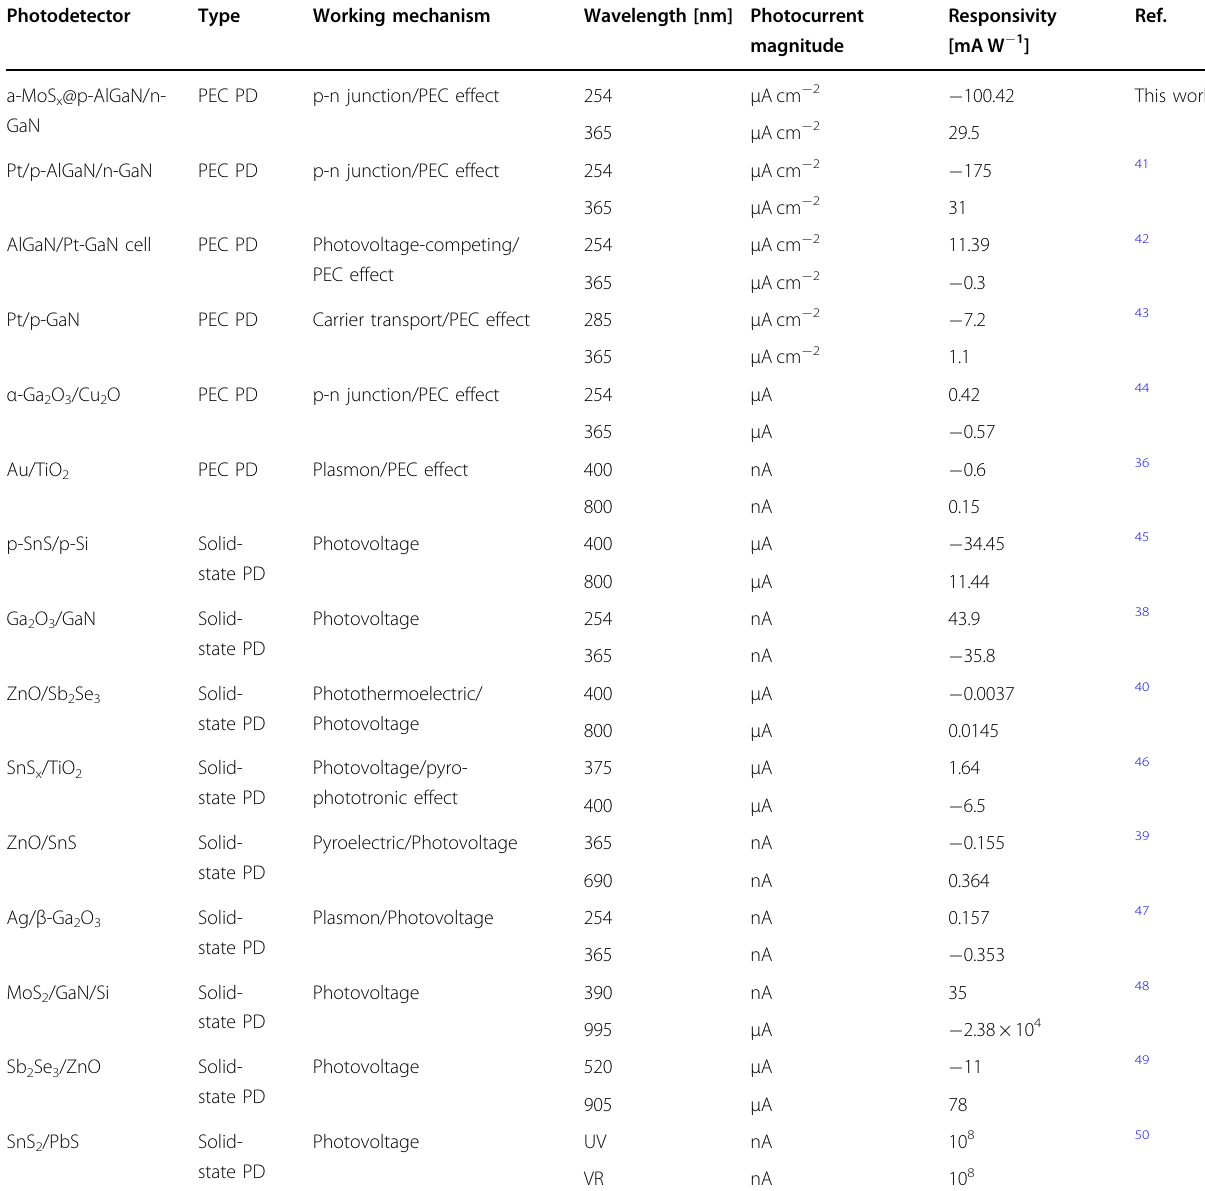
Table 1 Performance comparison of a-MoS switchable